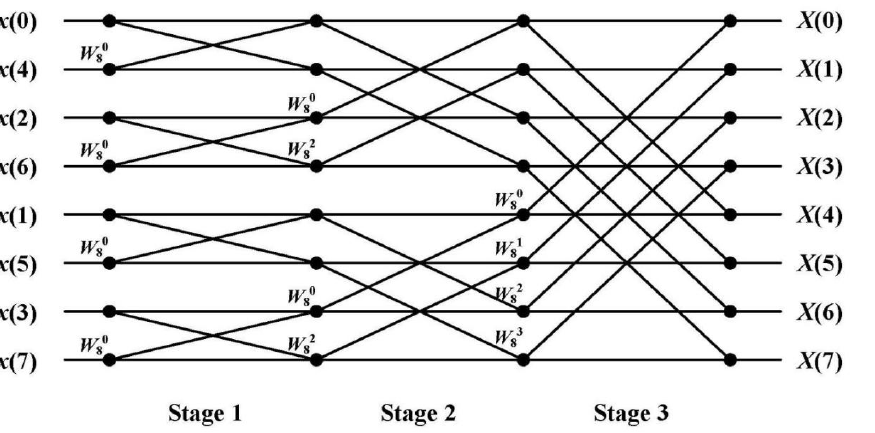
Figure 1. Eight-point DIT-NTT data flow